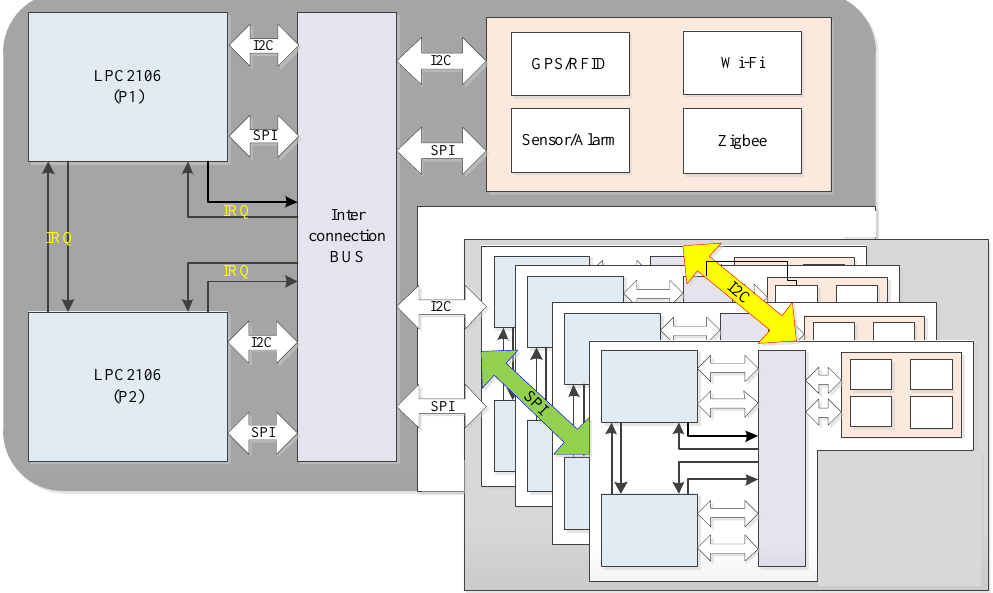
Figure 2. Fault-tolerant component-based architecture of Mobi+